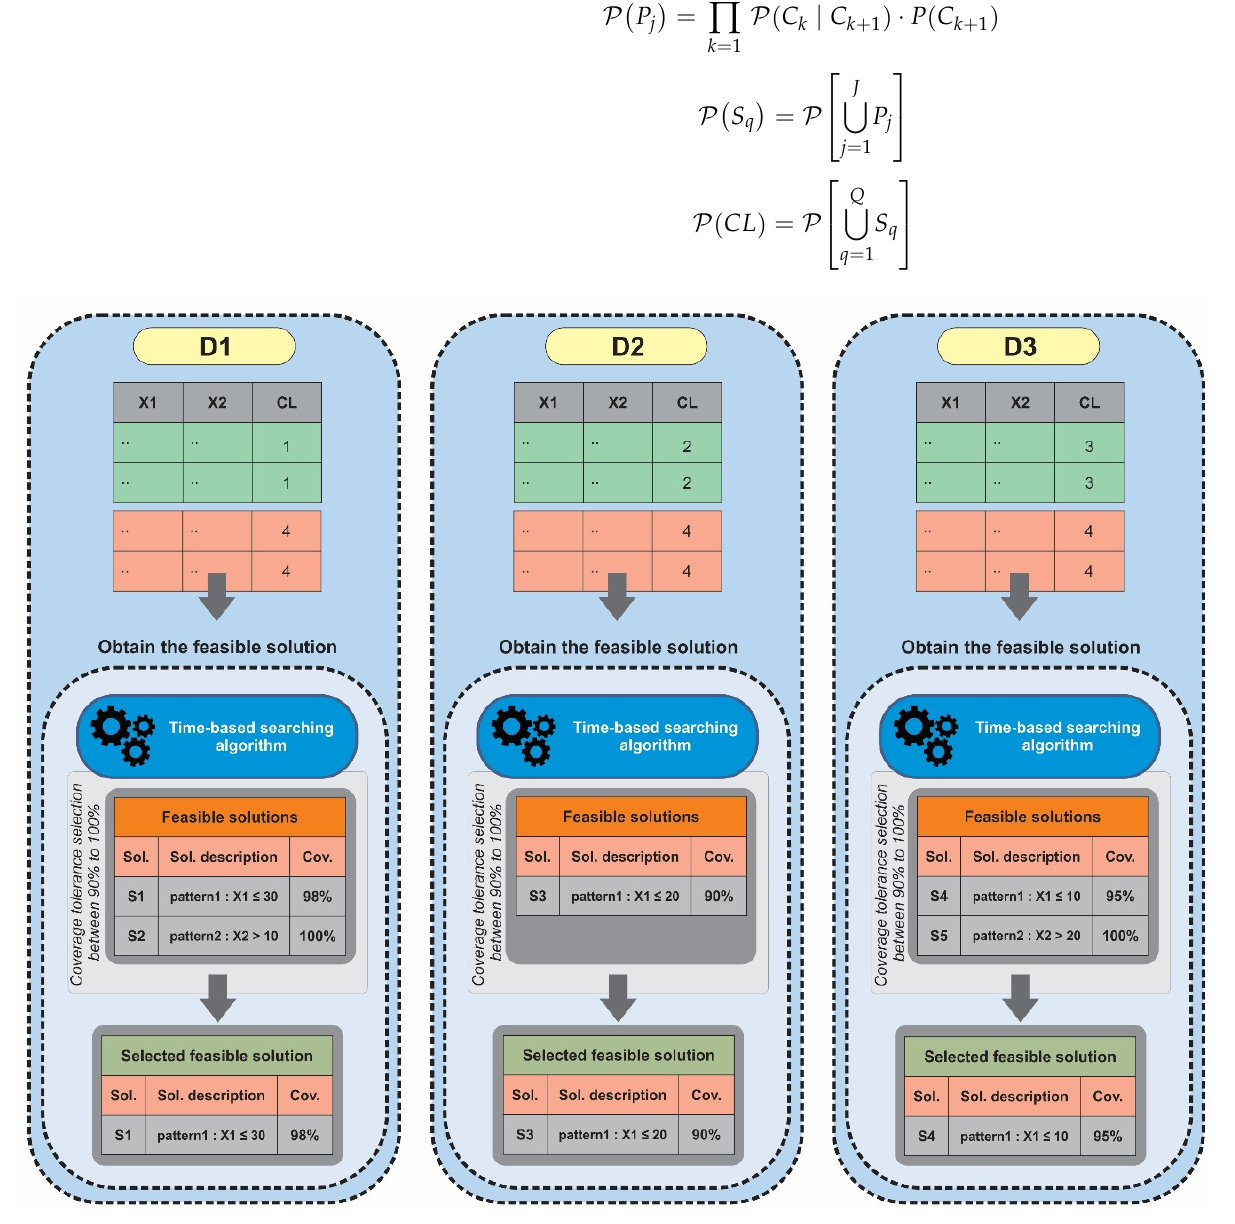
Figure 3. Example of selecting similar feasible solutions over the periods Δ 1 , Δ 2 , and Δ 3 .